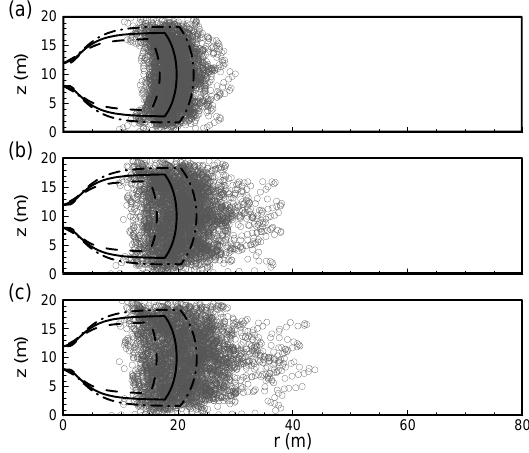
Fig. 9. Stochastic remediation zones obtained by using NSM (solid lines: mean, dashed lines: mean- σ R , and dash-dotted line:mean+ σ R ) and MCS (symbols) at t = 80day for fixed lnK variance of 0.5 and r -correlation length ( λr ) of (a) 1.0m, (b) 5.0m, and (c)